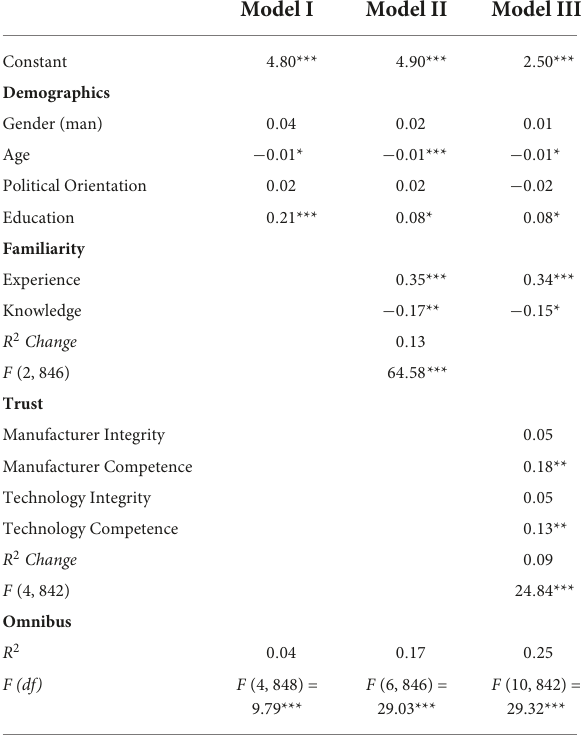
TABLE 4 Study 2b (airplane domain) regression models predicting adoption